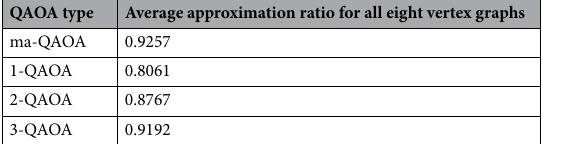
Table 2. The average approximation ratio for all connected, non-isomorphic graphs eight vertices.